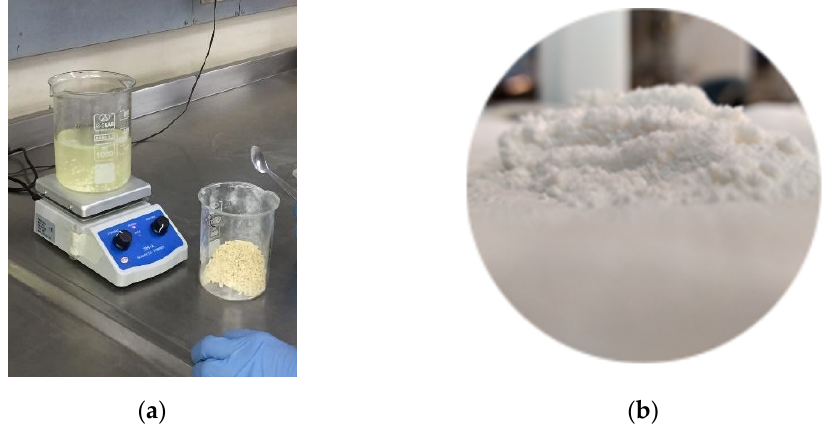
Figure 2. Biotechnological product BAC: ( a ) cultivated bacteria with nutrients; ( b ) lyophilized bacteria.